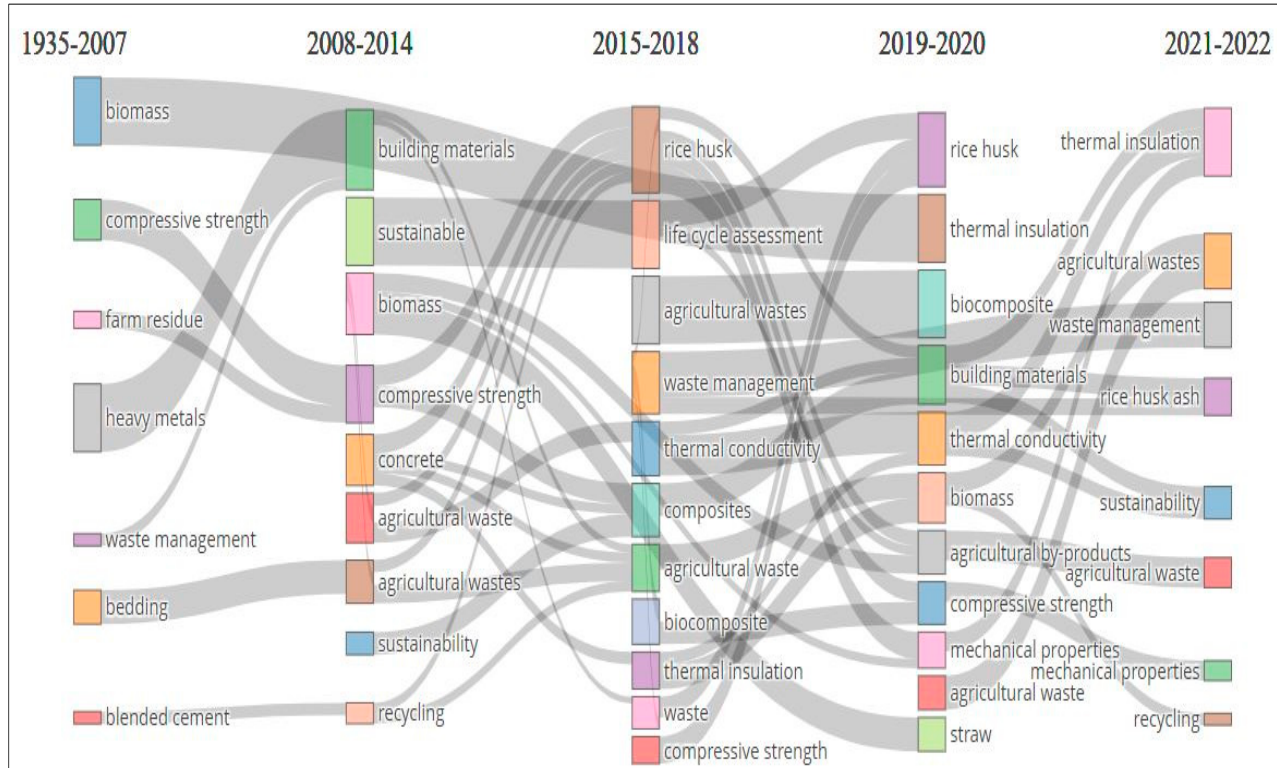
Figure 12. Keywords for future direction.